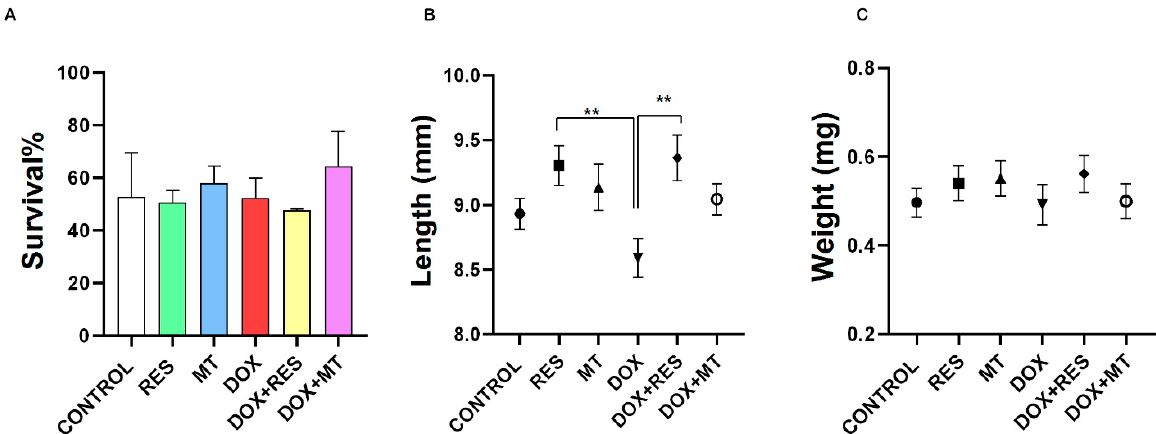
Figure 1. Survival and growth parameters of gilthead seabream larvae at the end of the trial. Survival of seabream ( A ), total length ( B ), dry weight ( C ). One-way ANOVA, Tukey’s multiple comparisons test, **— p ≤ 0.01. Acronyms: resveratrol (RES), doxorubicin (DOX), MitoTEMPO (MT), doxorubicin + resveratrol (DOX+RES) and doxorubicin + MitoTEMPO (DOX+MT).